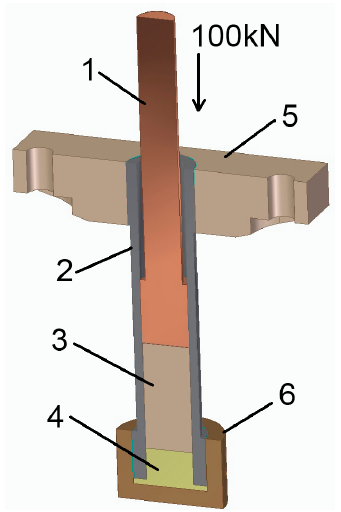
Figure 1. Construction and cross-section of the stand for biomass compaction. 1: piston; 2: bushing of compaction die; 3: compacted biomass; 4: replaceable spacer for adjustment of die height; 5: mounting for die; 6: die cover.